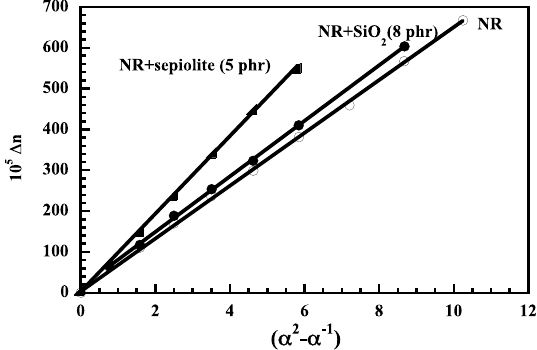
Figure 7. NR/sepiolite (5phr) composite: ( a ) TEM micrograph (Reproduced with permission from [27]. Copyright Elsevier, 2005); ( b ) stress-strain curve in addition to that of the unfilled rubber and with NR filled with 8 phr of in situ precipitated silica.